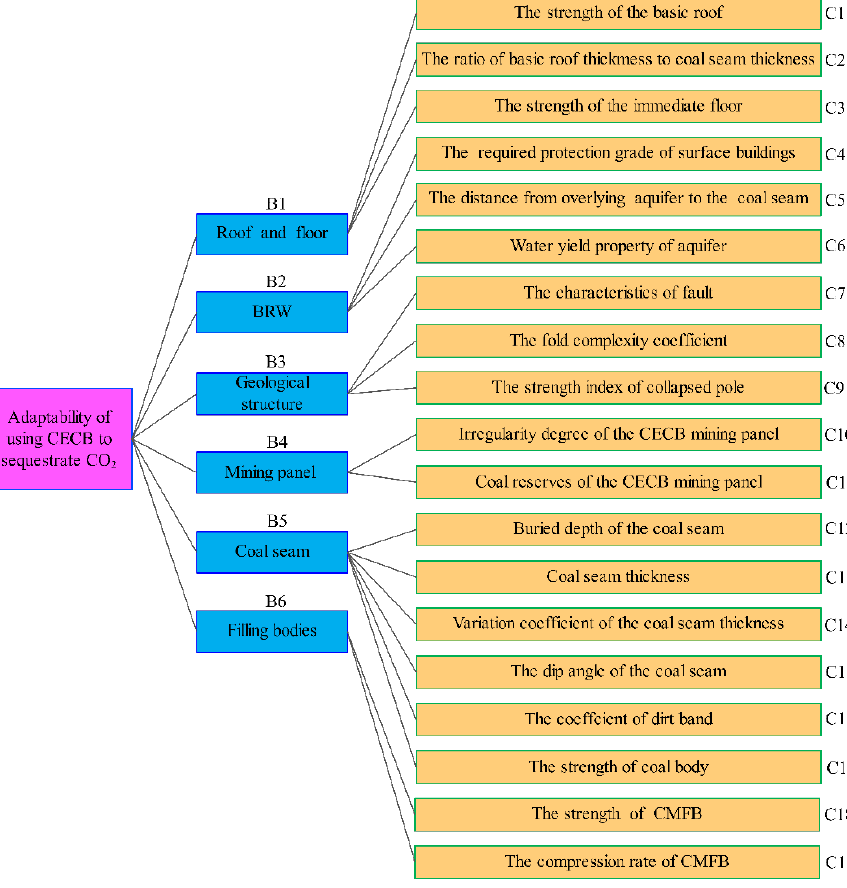
Figure 7. The hierarchy structure for evaluating the suitability of using CECB to sequestrate CO 2 .